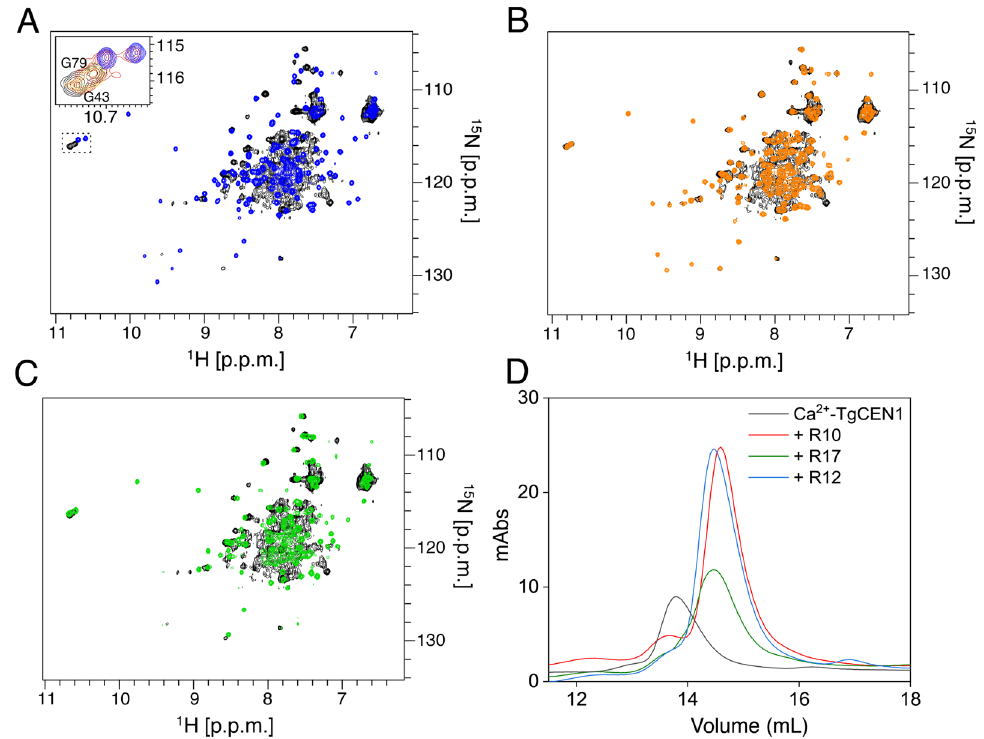
Figure 4. Conformational features of Ca 2+ -TgCEN1-peptide interaction. ( A ) 1 H- 15 N-HSQC spectra of Ca 2+ -TgCEN1 in the absence (black) and presence (blue) of 2.5 molar excess of R10. The figure inset box contains the chemical shift changes of the two N-terminal glycines at position 6 of the EF-hand binding loop (G43 and G79) during the titration. Selected protein:peptide molar ratios are 0 (black), 0.5 (yellow), 1 (red), and 2.5 (blue). ( B ) 1 H- 15 N-HSQC spectra of Ca 2+ -TgCEN1 in the absence (black) and presence (orange) of 2.5 molar excess of R17. ( C ) 1 H- 15 N-HSQC spectra of Ca 2+ -TgCEN1 in the absence (black) and presence (green) of 2.5 molar excess of R12. ( D ) SEC profiles of Ca 2+ -TgCEN1 alone (black line) and in complex with R10 (red line), R17 (green line) or R12 (blue line) peptides. All runs were performed on a Superose 12 10/300 GL column in buffer containing 5 mM CaCl 2 . In all runs, the same concentration of Ca 2+ -TgCEN1 (2 mg/mL) was used and a 1:2 molar ratio of R10 peptide and 1:1 molar ratio of R17 or R12 peptides was added.